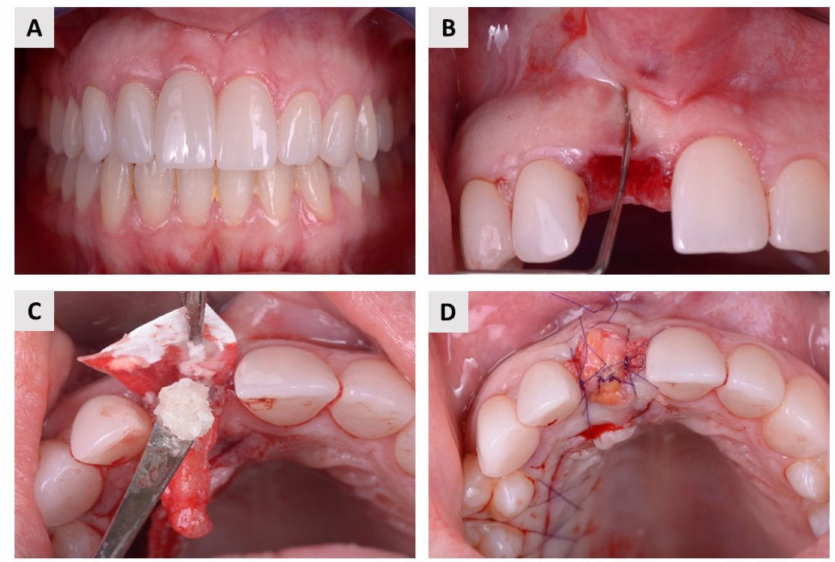
Figure 4. Surgical protocol in the test group. ( A ) The patient suffered from internal root resorption of the maxillary central incisor. ( B ) After atraumatic extraction, the integrity of the alveolar bone walls was checked with a dental probe. ( C ) An autologous dentin graft was placed in the extraction socket and covered with a resorbable membrane. ( D ) Finally, the wound was primary closed with connective tissue graft.